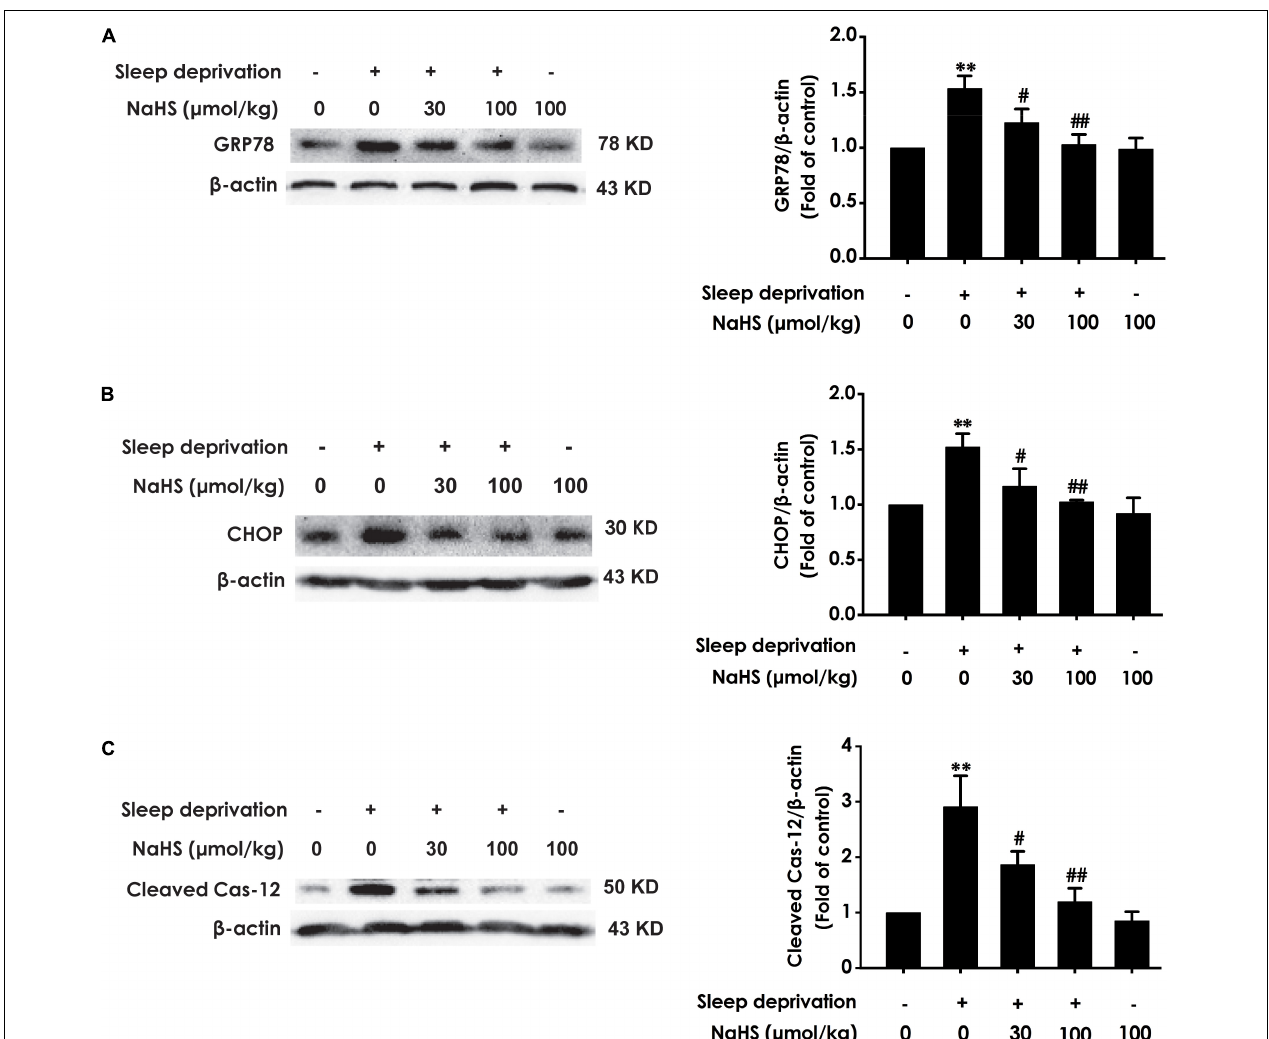
FIGURE 2 | Effect of hydrogen sulfide on sleep deprivation-induced hippocampal ER stress in rats. Rats were pretreated with NaHS (30 and 100 µ mol/kg/d, ip) for 7 days and then cotreated with SD for 72 h. The expression of CPR78 (A) , CHOP (B) , and cleaved caspase-12 (C) were detected by western blotting. In all blots, β -actin was used to determine control. Values are the means ± SEM ( n = 3). ∗∗ P < 0.01, vs. control; # P < 0.05, ## P < 0.01, vs. SD-treated alone